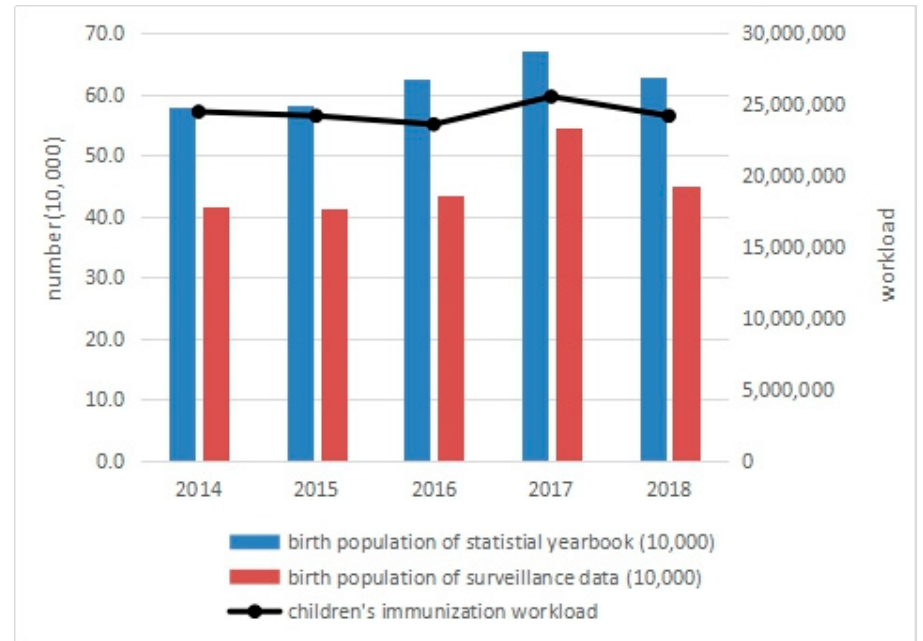
Figure 4. Children’s immunization workload in Zhejiang Province, 2014–2018.